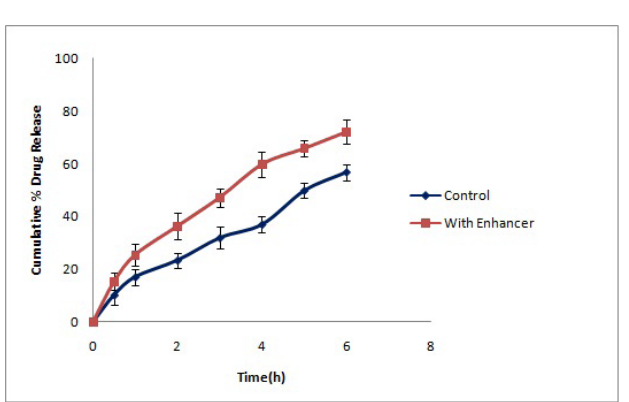
FIGURE 5 - Ex-vivo release profile of hydralazine hydrochloride muco-adhesive buccaltablets.